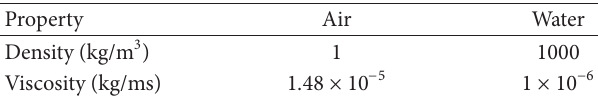
Table 1: Fluid properties.